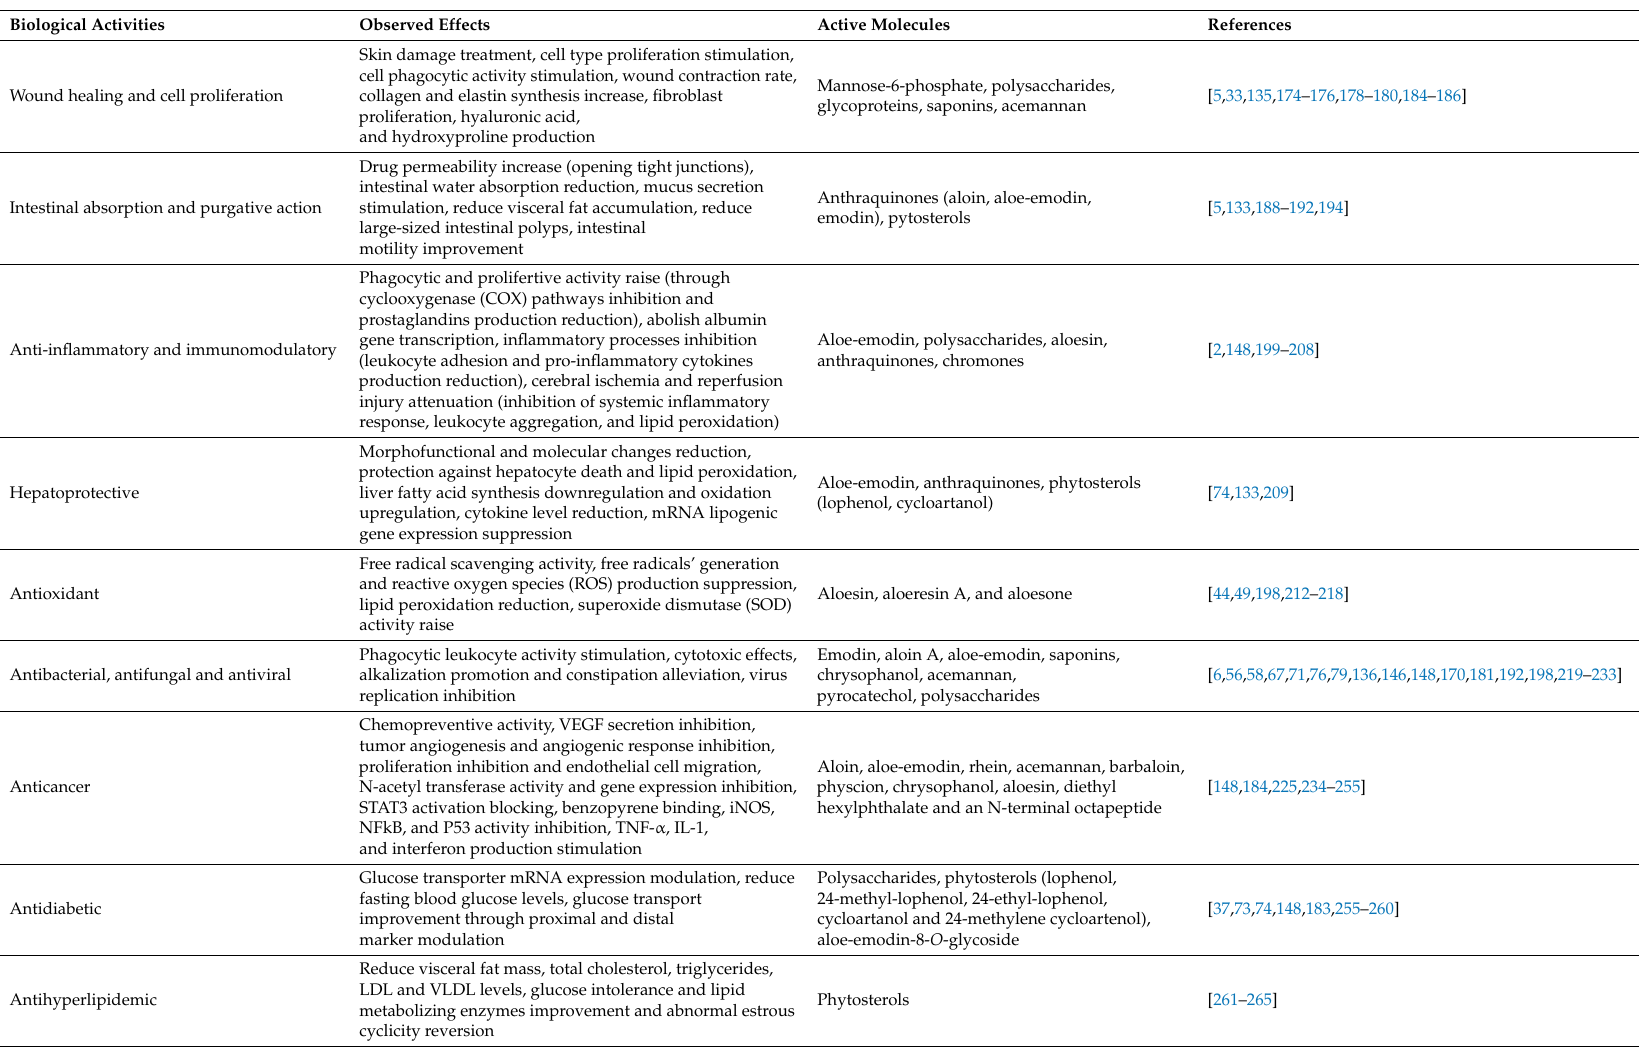
Table 6. Bioactive effects of Aloe plant species: pre-clinical (in vitro and in vivo)